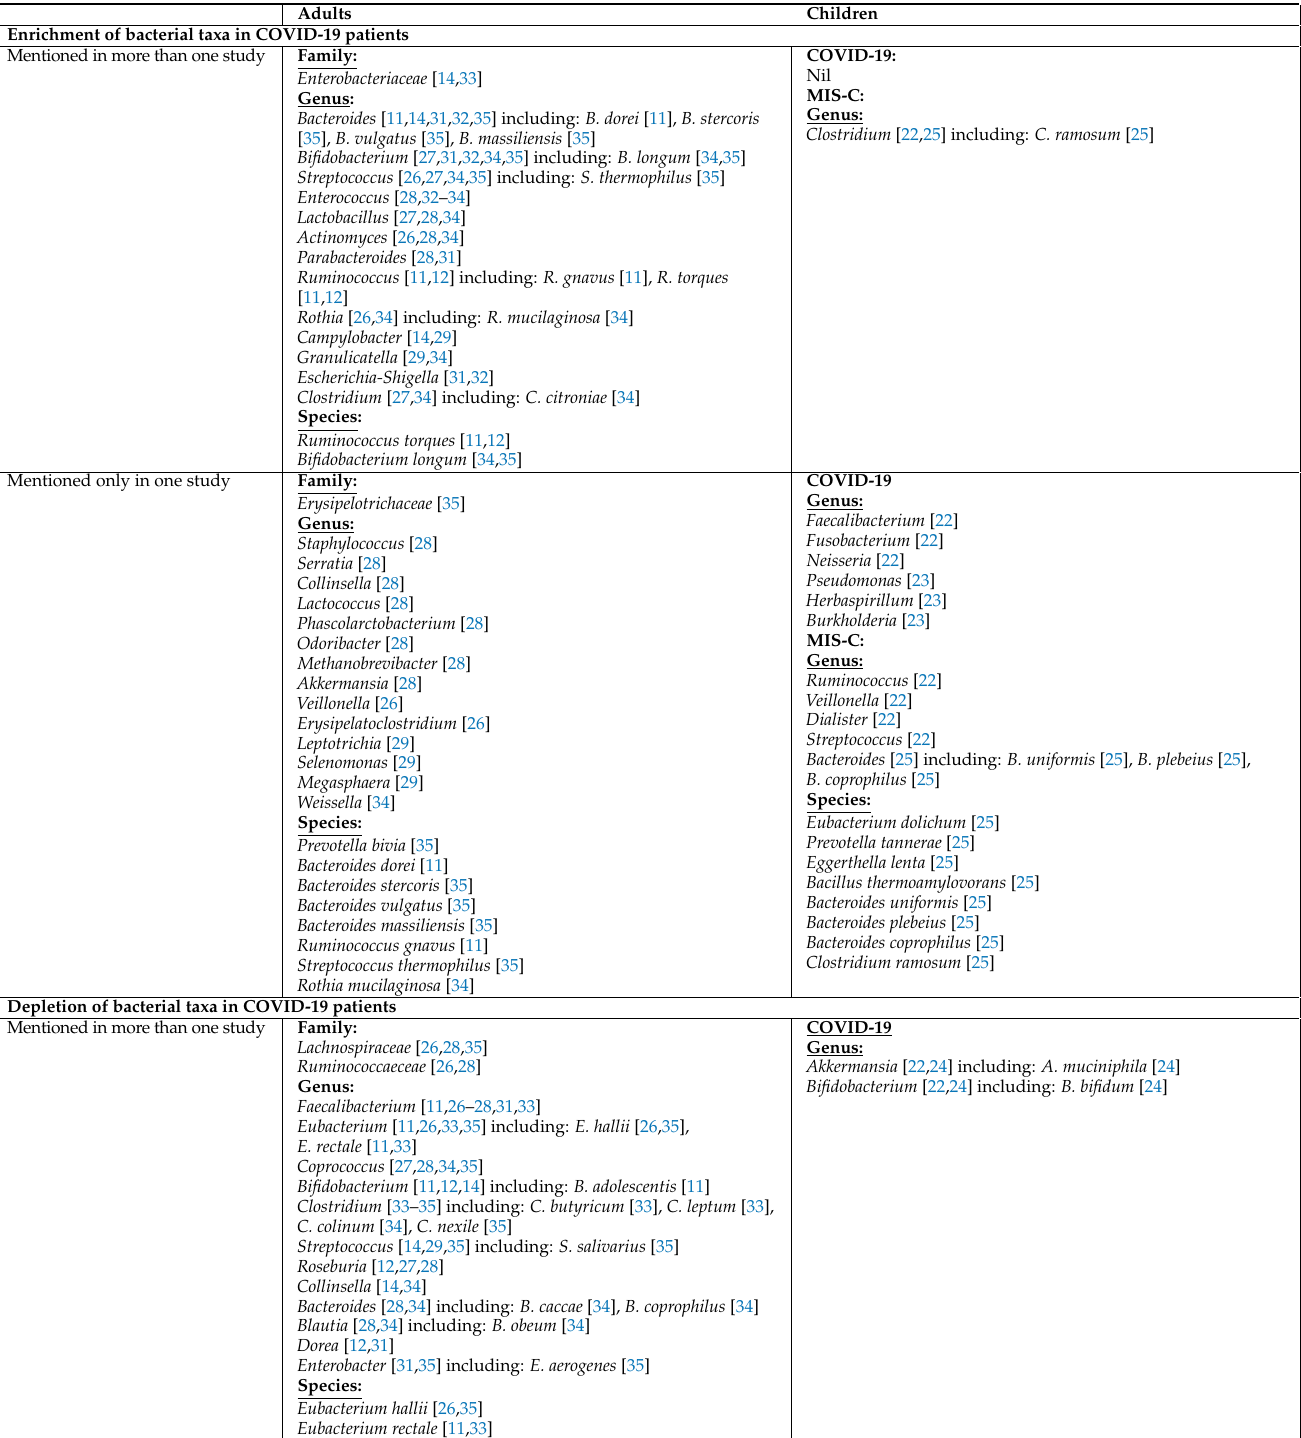
Table A1. Enrichment and depletion of bacterial taxa in COVID-19 patients with frequency of reports in current